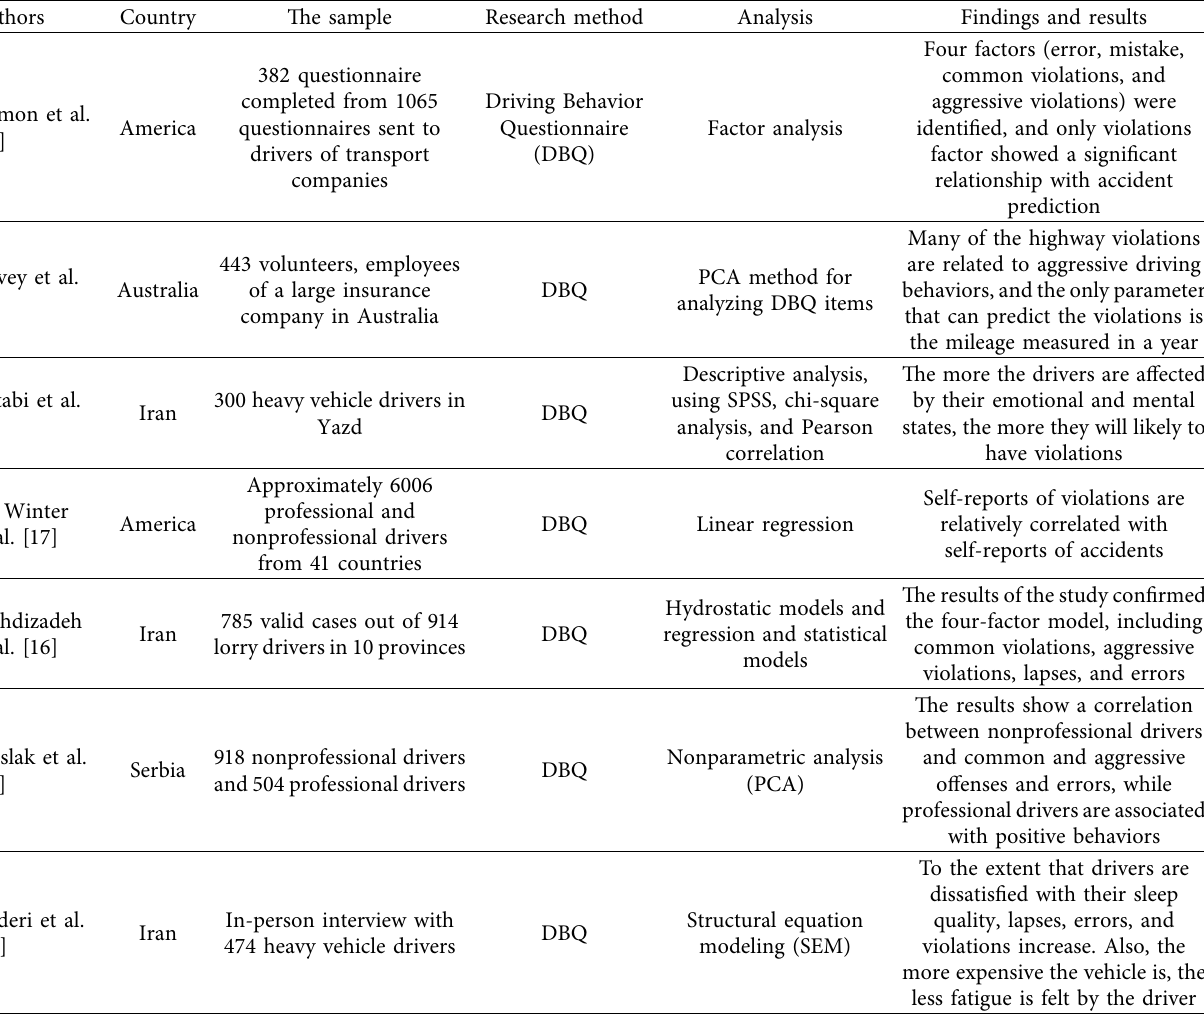
Table 1: Summary of studies on lorry drivers’ behavior